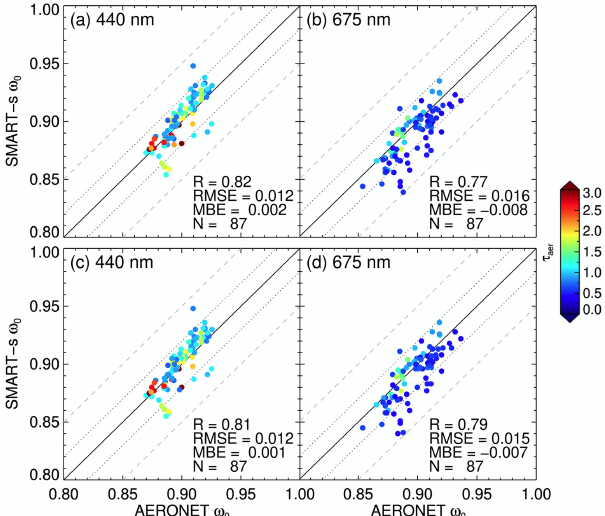
Figure 6. Comparison of single scattering albedo ( ω 0 ) from SMART–s and AERONET (version 3, level 2.0) at (a) 440nm and (b) 675nm from 19 March to 2 May 2019. In these two panels, the SMART–s algorithm utilized solar irradiance from Coddington et al. (2021). Panels (c) and (d) are similar plots to panels (a) and (b) but for SMART–s retrievals using derived solar irradiance in this study. Colored circles represent values of aerosol optical thickness ( τ aer ) from the color bar at each wavelength. R is the correlation coefficient, RMSE denotes the root mean square error, MBE is the mean bias error, and N is the number of samples for the compari- son. The dotted and dashed lines represent, respectively, the relative biases of ± 0 . 02 and ± 0 . 05 from the AERONET